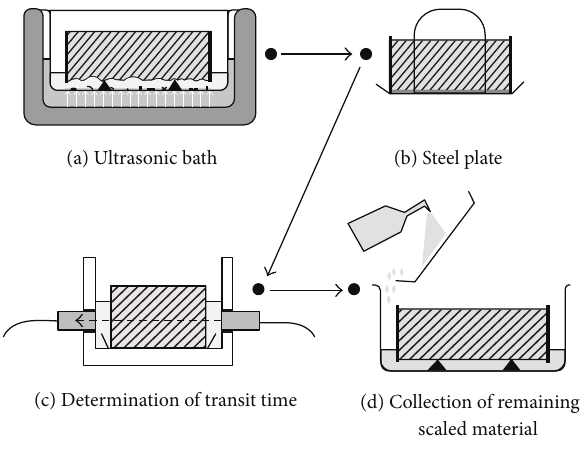
Figure 6: Specimen handling (reference method) [22].